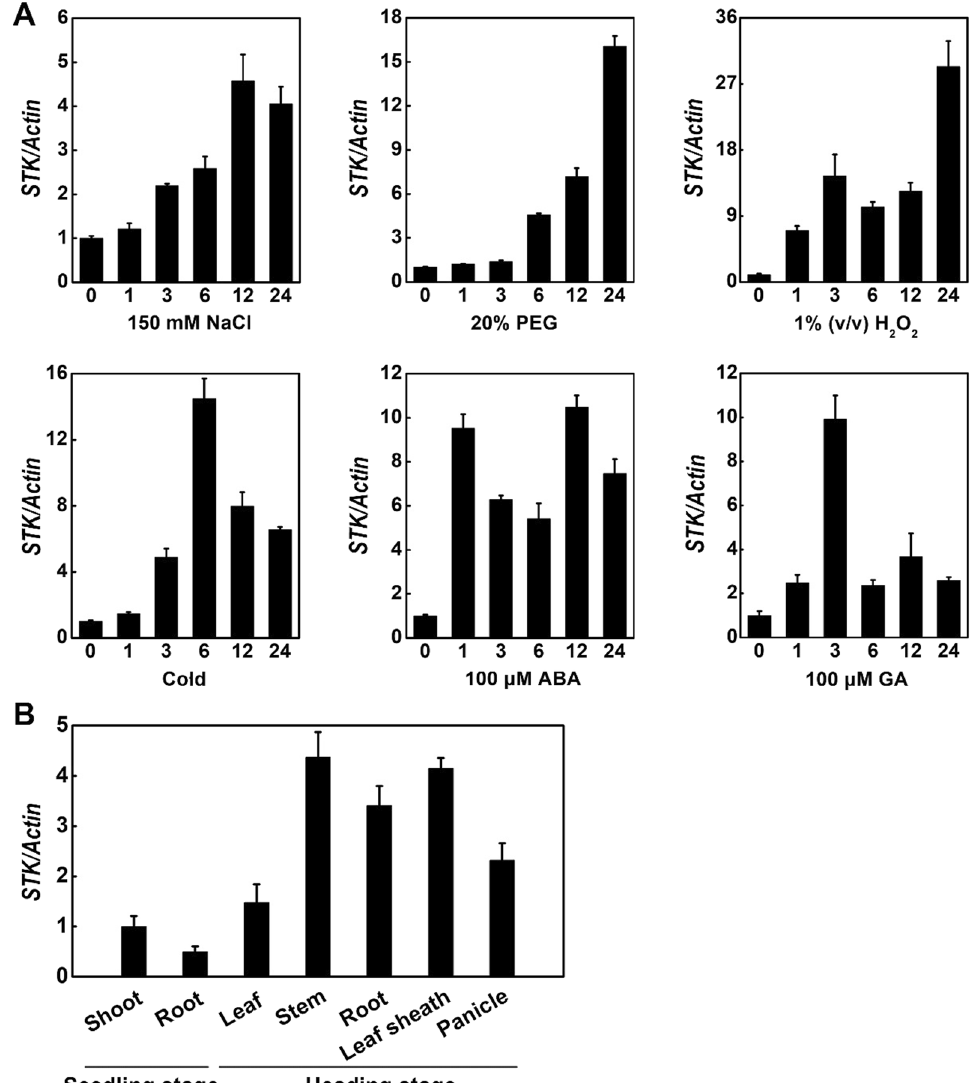
Fig. 1 Expression patterns of STK . A Expression profiles of STK in Kitaake rice seedlings in response to salt, drought, H 2 O 2 , cold, ABA and GA treatments using RT-qPCR. B Expression of STK in various tissues of rice cultivar Kitaake at different stages using RT-qPCR. Data are